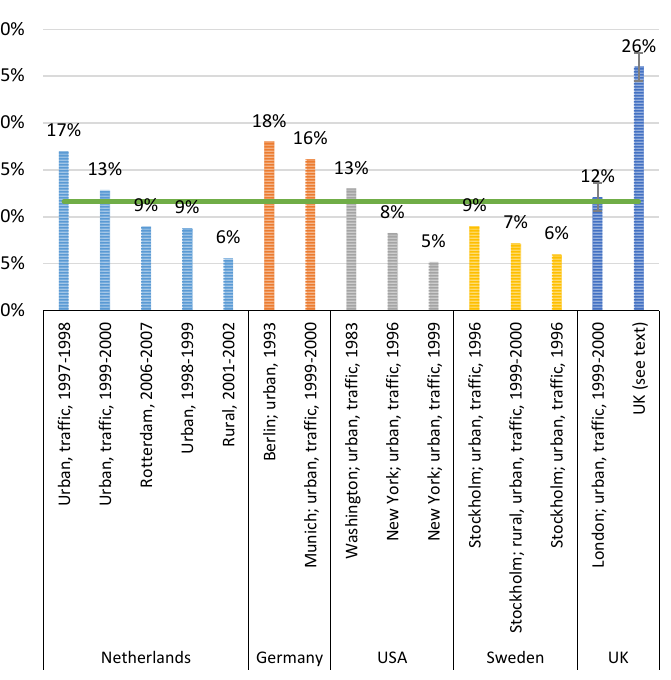
Figure 1. Percentage EC content in BS in the different studies. The green line corresponds to the mean value of 12%. The studies are presented in more detail in Table S1.